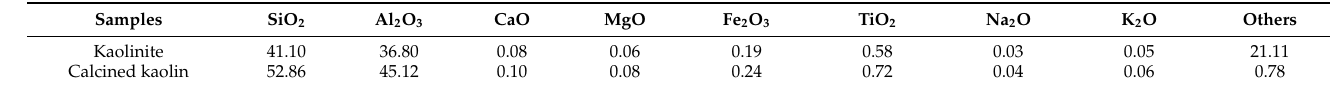
Table 1. Chemical constituent of kaolinite and calcined